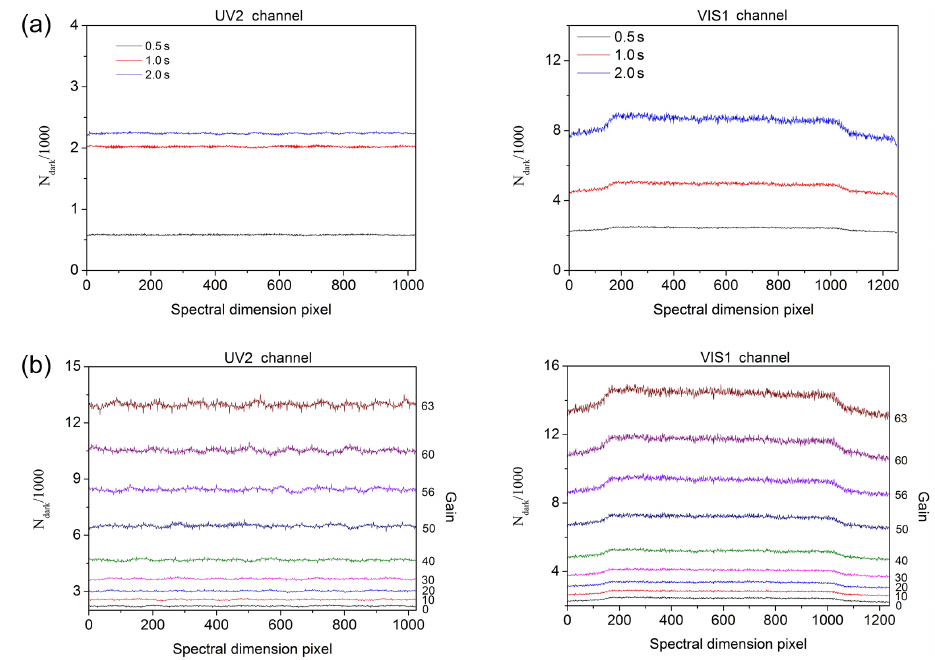
Figure 8. (a) Dark signal for different integration time. (b) Dark signal under different gain steps. The gain steps are set to 0, 10, 20, 30, 40, 50, 56, 60, and 63. The pixels in the readout register cannot be used to accomplish the binning due to the full well limitation. In this case, the pixel binning is accomplished in the Field Programming Gate Array. Fast readout frequency is needed for the process. The fast readout frequency leads to signal distortion. Therefore, the difference between the measurements with 0.5 and 1.0s integration times is not half of the difference between the measurements with 1.0 and 2.0s integration times. Based on the signal distortion, we have obtained absolute radiance calibration key data at different integration time on the ground. The calibration key data are used for the L1b data